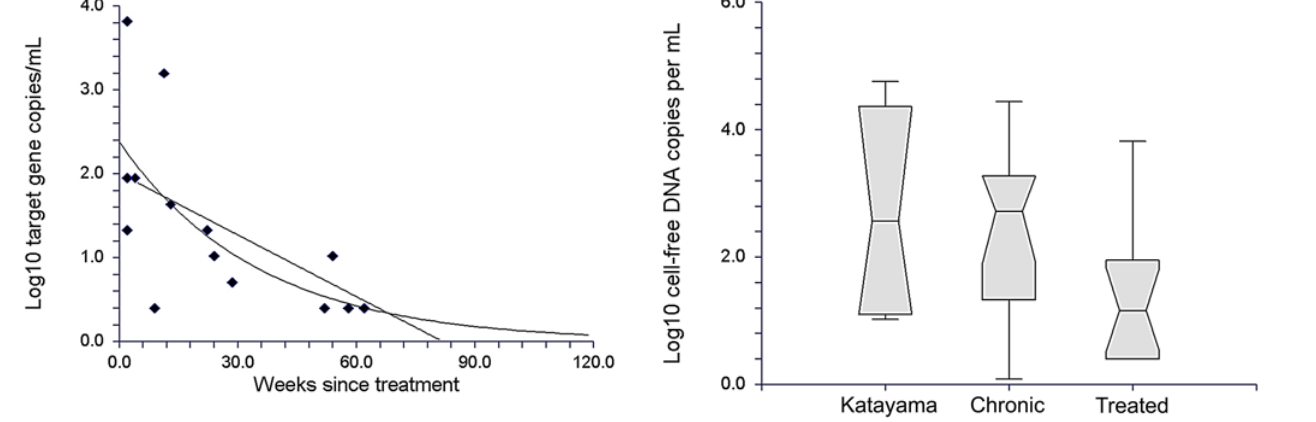
Figure 3. Cell-free Schistosoma DNA concentrations after treatment. DNA concentrations were plotted only for those patients still showing cell-free Schistosoma DNA in plasma after treatment. These data were pooled from patients who had been followed prospectively after being diagnosed with Katayama syndrome, as well as from patients examined retrospectively after concluded treatment. Linear regression analysis yielded the graph equation Y=2.03 2 0.02 X. Exponential regression yielded the graph equation Y=e ‘ 2 0.02 (X 2 30.4).